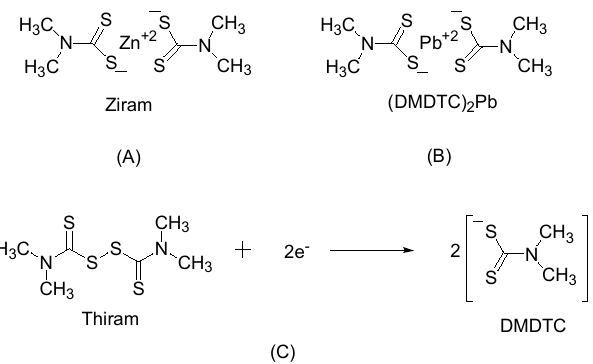
Figure 2: Schematic representation of (A) Ziram (Borg and Tjaelve, 1988); (B) The complex between Pb and Thiram (Valle et al ., 2010); (C) S-S bond cleavage of Thiram (Valle et al ., 2010; Sanchez-Cortes et al ., 1998; Kang et al .,